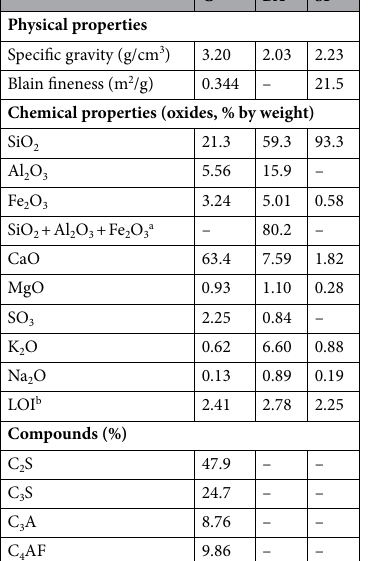
Table 1. Physical and chemical properties of cement, BA and SF. a ASTM C618; b LOI = loss on